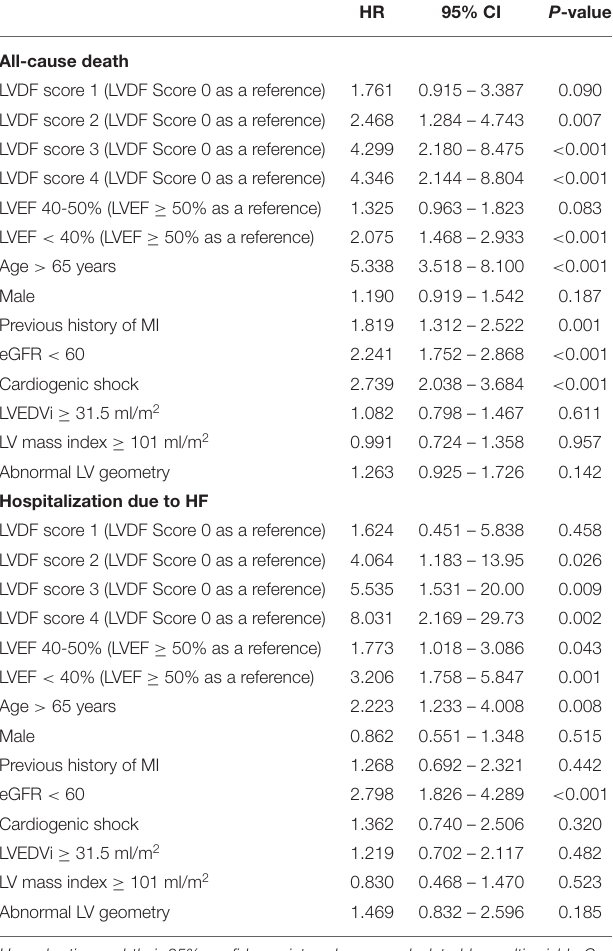
TABLE 3 | Independent Predictors for All-cause Death And Hospitalization Due to HF. HR 95% CI P -value vessel ( Supplementary Figure 3 ). Comparison of the predictive performance of the individual LVDF parameters and LVEF showed that E/e’ ratio was the best predictor of all-cause death and HHF ( Supplementary Figure 4 ).